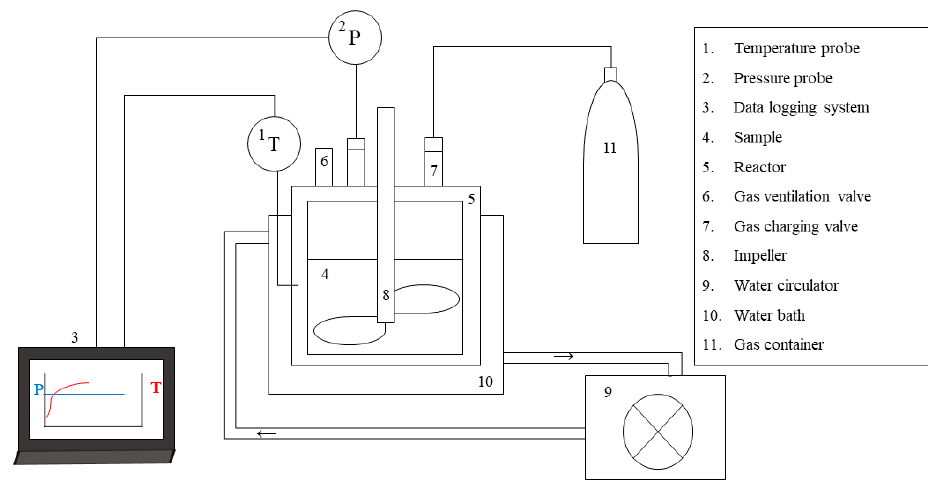
Figure 2. Diagram of the reaction system for HbQF.